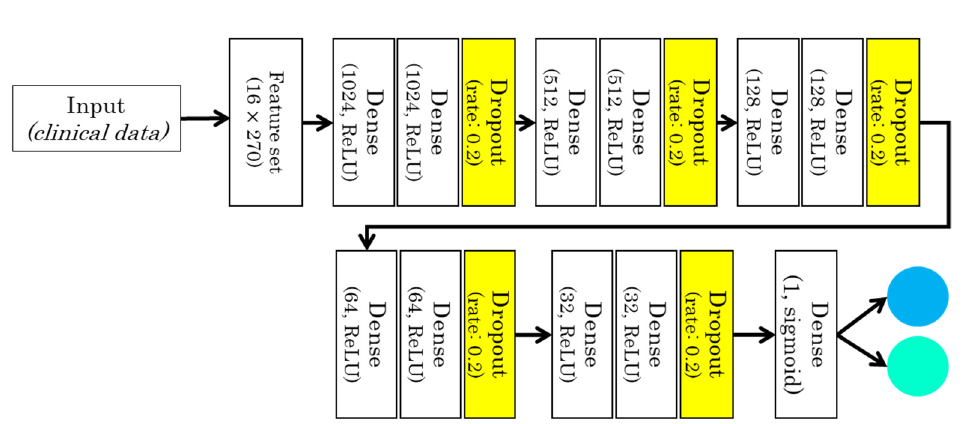
Figure 3. Deep Learning model for the clinical data (case 1).